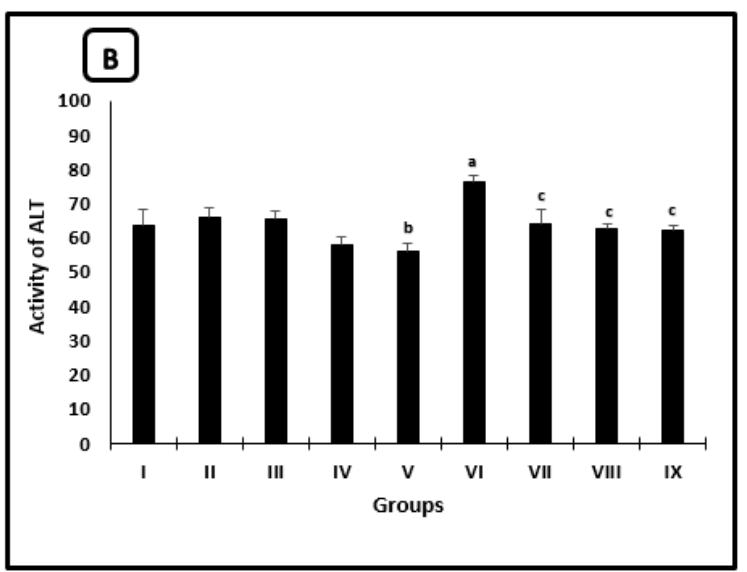
Groups I, II, III, IV, and VI presented saline, PB, PZQ, AL and CU uninfected treated-mice, groups